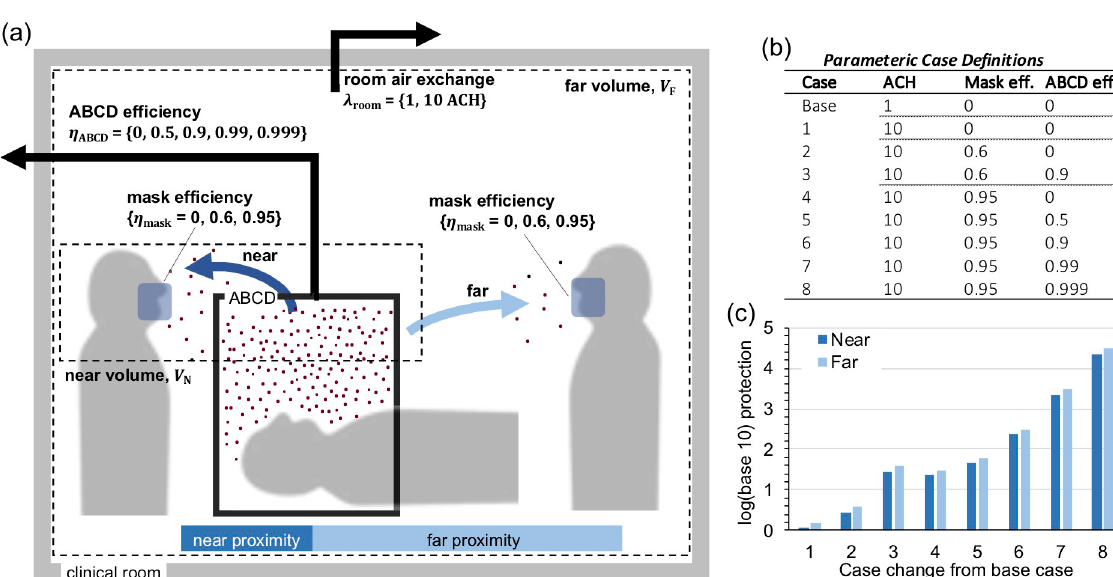
Fig 5. Log-risk-reduction framework. (a) Schematic of framework used to simulate impact of ABCD in a hypothetical clinical setting, using a two-zone well-mixed model. Patient emitted aerosols that escape the ABCD enter the near volume, in which exists a near proximity clinical worker, and then aerosols are transported from the near volume into the far volume, in which exists a far proximity clinical worker. (b) Table of nine simulated cases with different levels of protections, which started at a low protection base case and then increased protections to the highest simulated combination of protections. (c) Log 10 protection according to inhaled dose of near and far proximity clinical workers for each protective case normalized by the base case (i.e., co-log 10 of dose ratios).